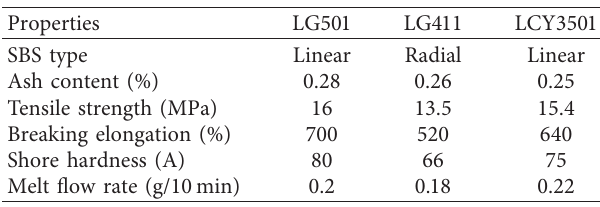
Table 2: Properties of SBS modifiers.